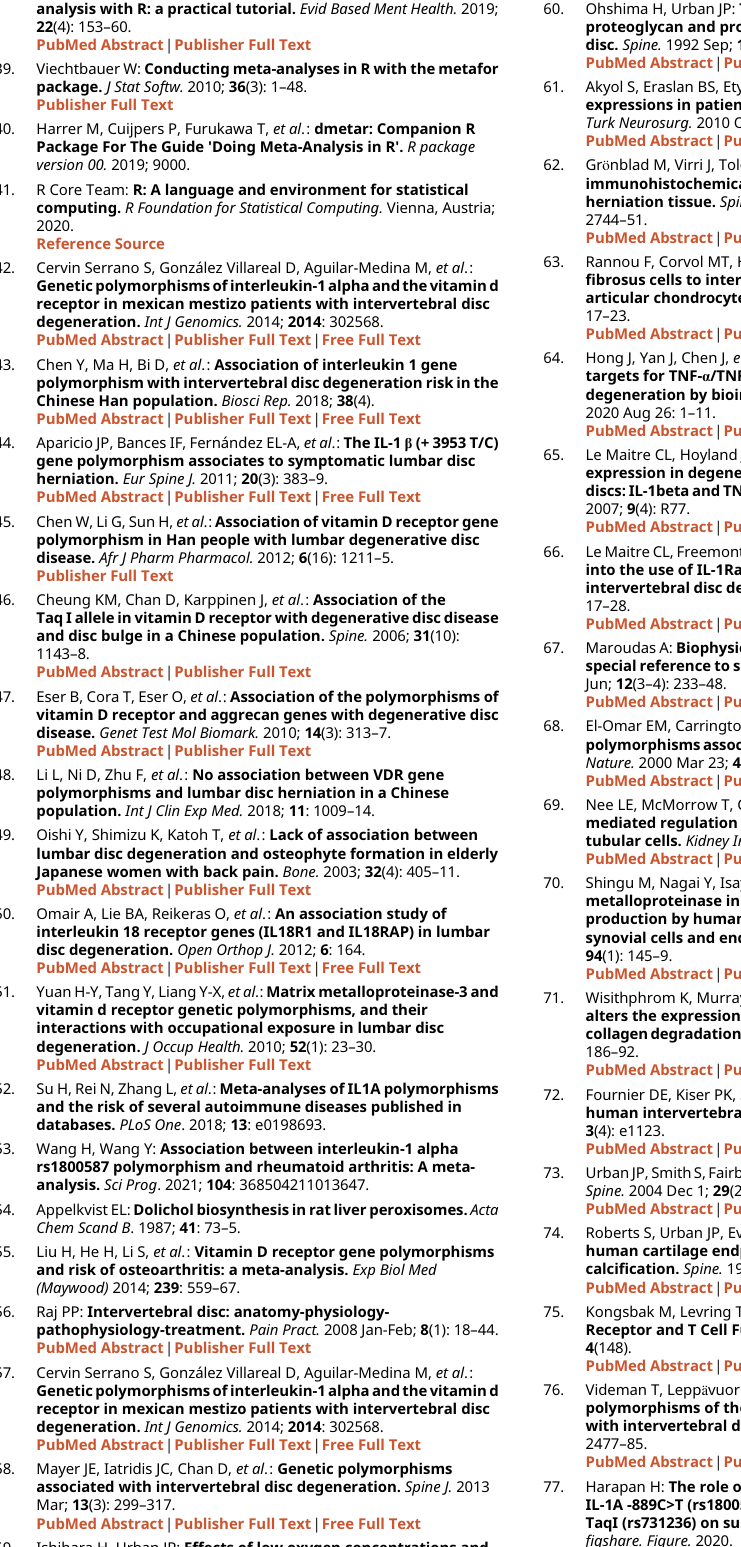
figshare. Figure. 2020. Publisher Full